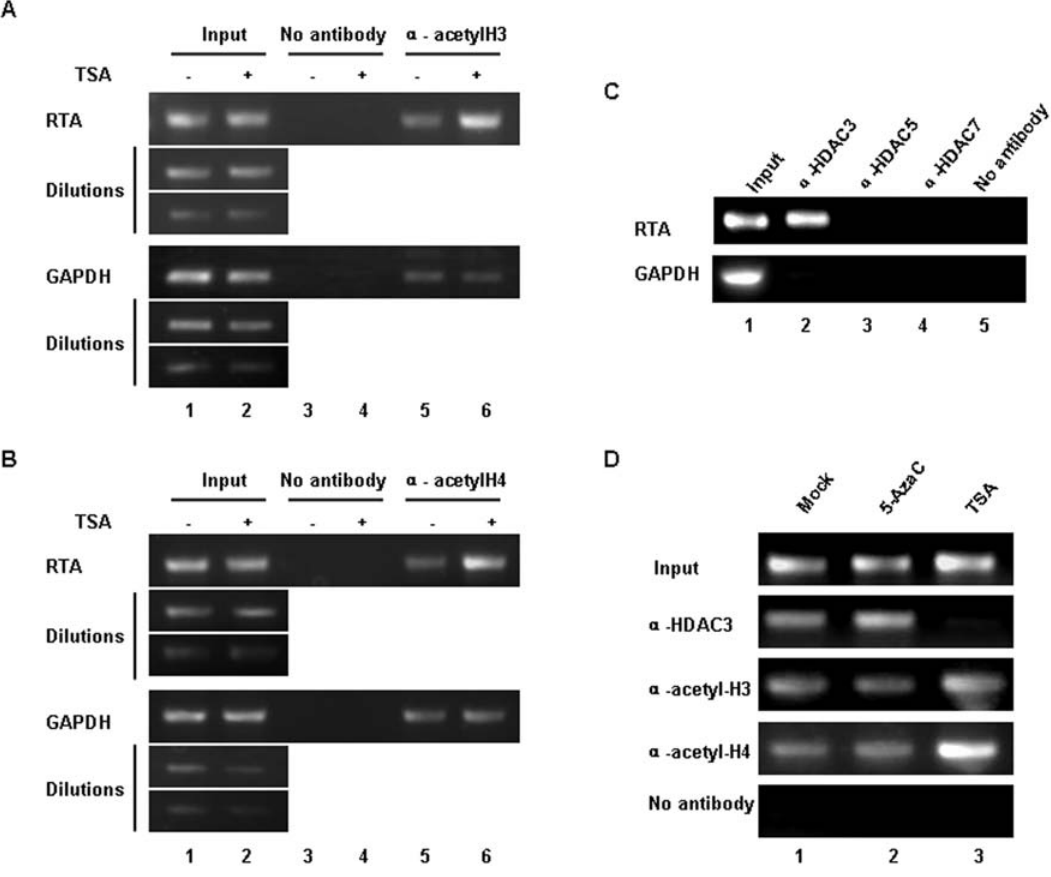
Figure 4. Histone acetylation modification at MHV-68 RTA promoter. (A) ChIP analysis of histone H3 acetylation level at MHV-68 RTA promoter. S11E cells were stimulated with TSA (200 ng/ml) for 4 hrs or mock-treated. Chromatin fragments were immunoprecipitated with an antibody against acetylated histones H3 (or no antibody control). Primers specific for RTA promoter or the GAPDH coding sequence were used to amplify the DNA isolated from the immunoprecipitated chromatin. The input DNAs and their dilutions were amplified to serve as positive controls. (B) ChIP analysis of histone H4 acetylation level at MHV-68 RTA promoter. Experiments were conducted as above, except an antibody against acetylated histone H4 was used. (C) HDAC3 was recruited to the MHV-68 RTA promoter. Recruitment of HDAC3, 5 or 7 to MHV-68 RTA promoter in S11E cells was investigated by ChIP. ChIP analysis of GAPDH coding sequence region is shown in the lower panel. Negative control (‘‘No antibody’’) and positive control (‘‘Input’’) were indicated. (D) ChIP analysis of HDAC3, acetylated histones H3 or acetylated histones H4 at RTA promoter. S11E cells were treated with 5-AzaC (10 m M, 36 hrs), TSA (200 ng/ml, 4 hrs) or left untreated, chromatin fragments immunoprecipitated and then analyzed by ChIP.